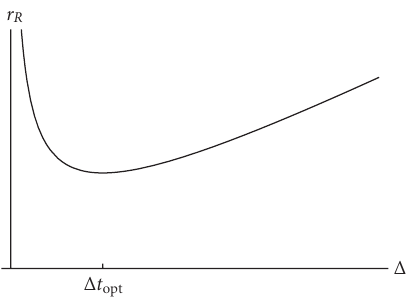
Figure 2.1. The total risk premium r R = r TC + r VP as a function of the time-lag ∆ t between two con- secutive portfolio